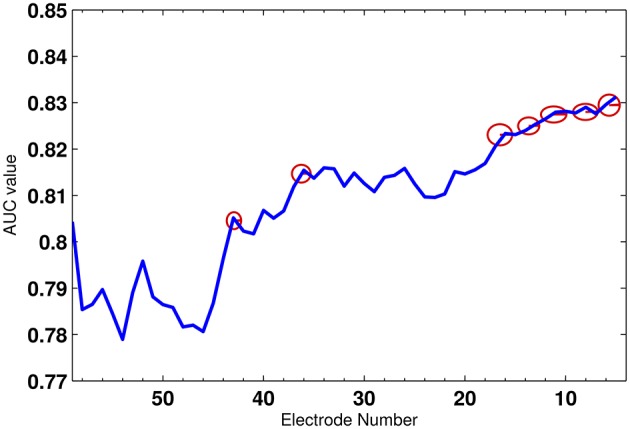
The average AUC value across 56 electrodes. The red circles mark the electrodes which were rejected.